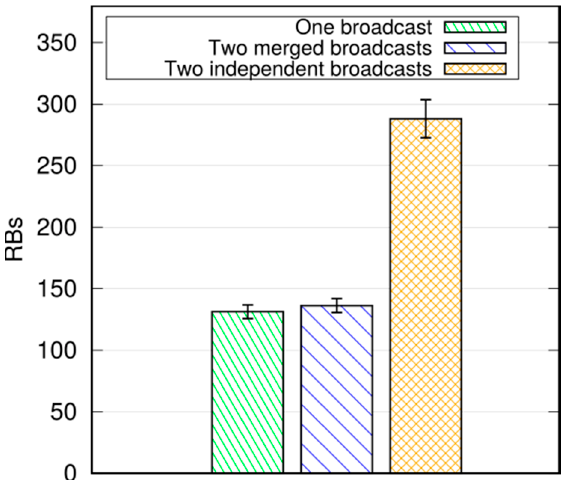
Figure 21. Avg. allocated RBs per broadcast with multiple broadcast sources.